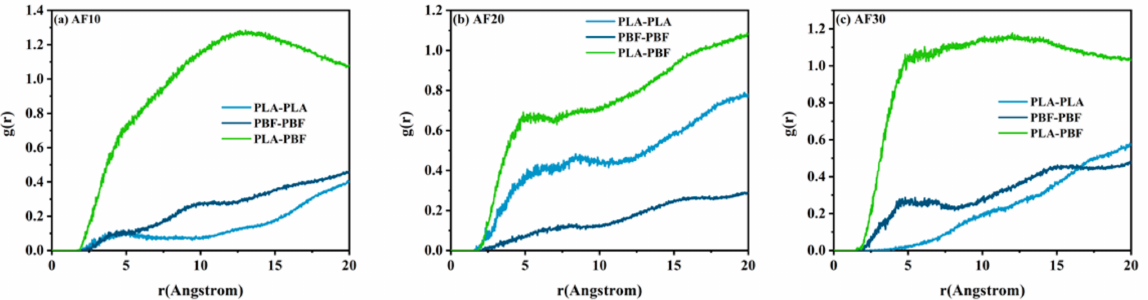
Figure 8. Radial distribution function of the inter-molecular carbon–carbon pairs of ( a ) AF10, ( b ) AF20, and ( c )